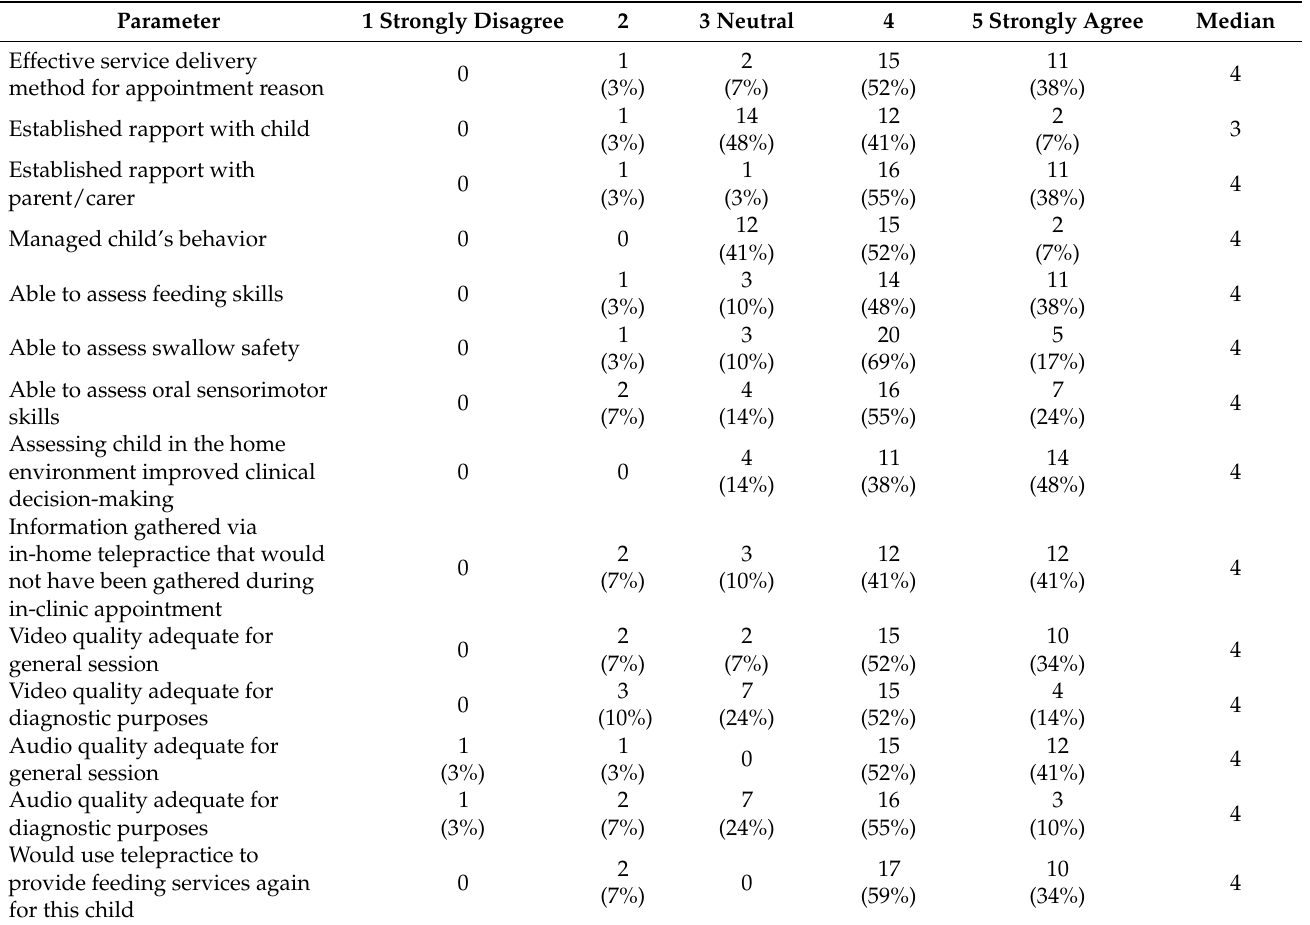
Table 4. Clinician satisfaction with telepractice assessments ( n = 29)